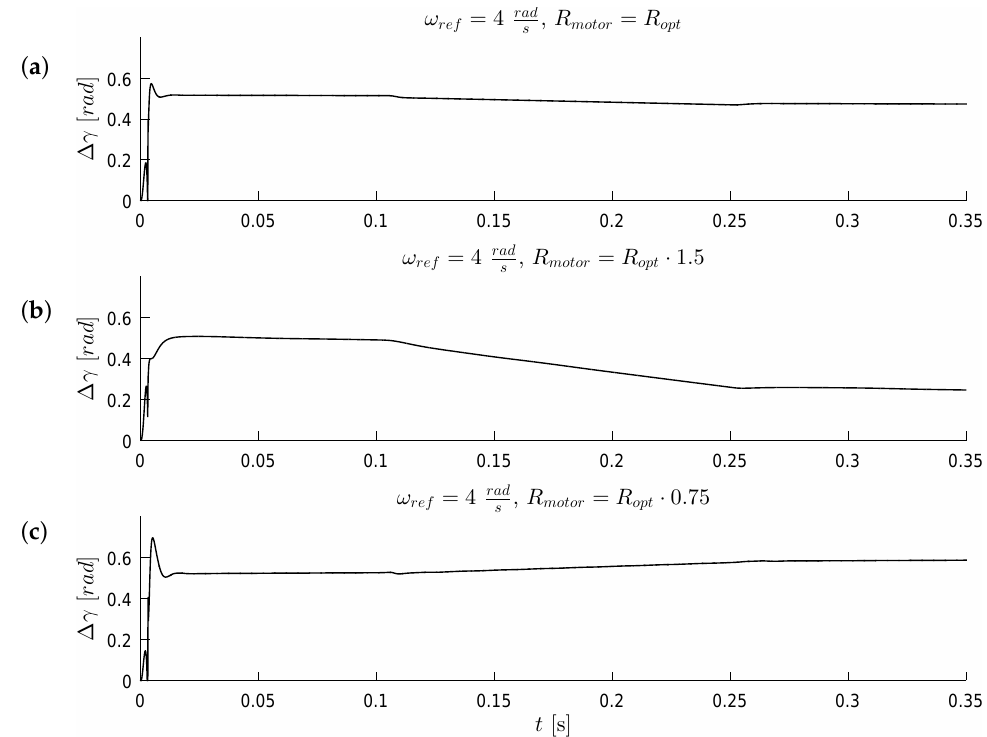
Figure 12. Waveforms of reference (model) i q different estimation errors of motor resistance (the initial position equals 30 ◦ ) ( a ) R motor = R opt , ( b ) R motor = 1.5 R opt , ( c ) R motor = 0.75 ·